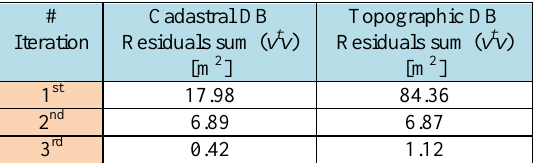
Figure 7. Detail showing a full geometric alignment of linear features with corresponding displacement vector fields Figure 8 depicts the alignment of subject polygon features from a cadastral database (dashed blue) with a topographic reference one (dashed green). While previous experiments showed results where one dataset is reference (high accuracy) while the other is subject (low accuracy), in this experiment both databases were considered to have the same accuracy, thus both had the same weights in the process. The top image depicts the entire area showing geometric discrepancies before the alignment, which vary up to 10 meters. The bottom image depicts the alignment results after three iterations, presenting a complete alignment of corresponding features (subject dataset overlays perfectly with reference). Table 1 shows that during the three iterations applied, the existing residuals ( v t v ) are reduced for both databases as the process progresses toward convergence, thus converging to the optimal mutual alignment solution.